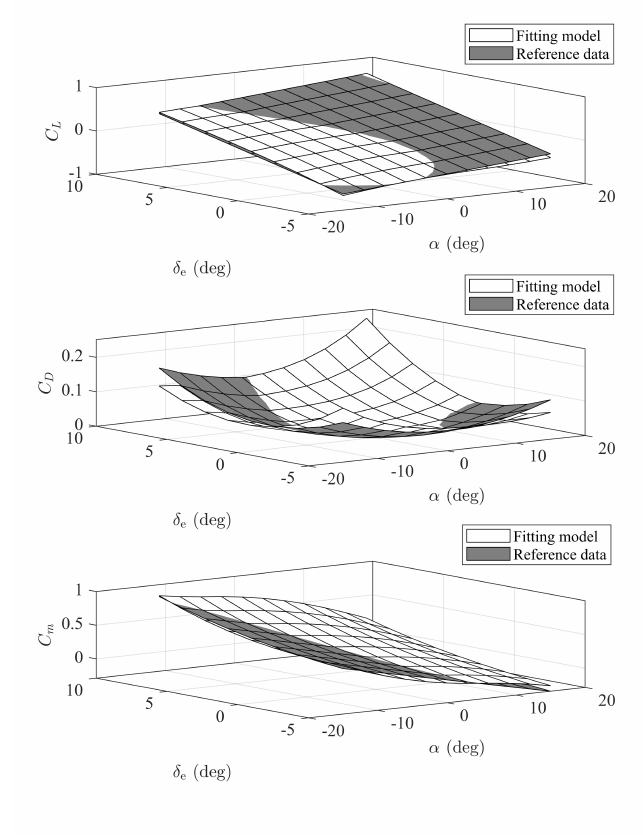
Figure 2. Comparison diagram for the aerodynamic model.